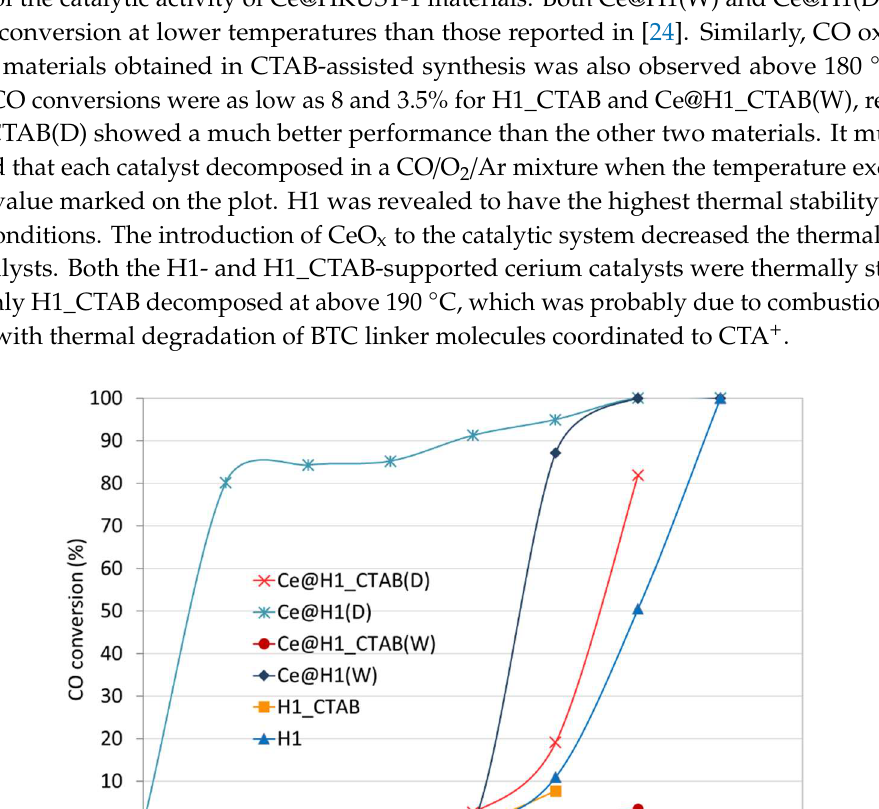
Figure 12. XRD for HKUST-1 and Ce@HKUST-1 catalysts after tests of CO oxidation.